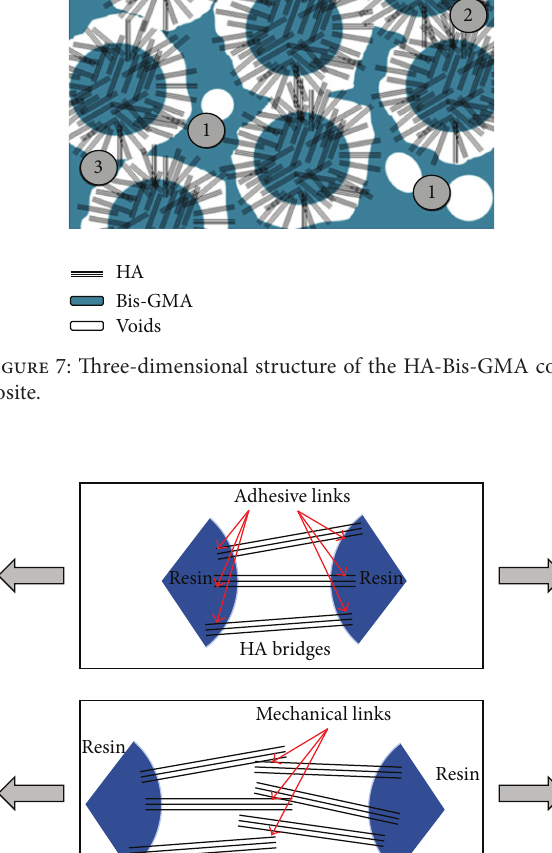
Table 5: Resultsofmechanical propertiesoffourevaluated compos- ites.